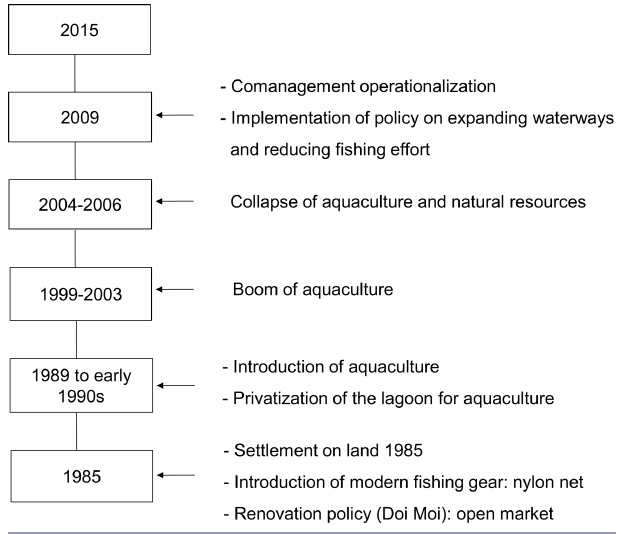
Fig. 3 . Key social-ecological changes in the Tam Giang lagoon between 1985 and